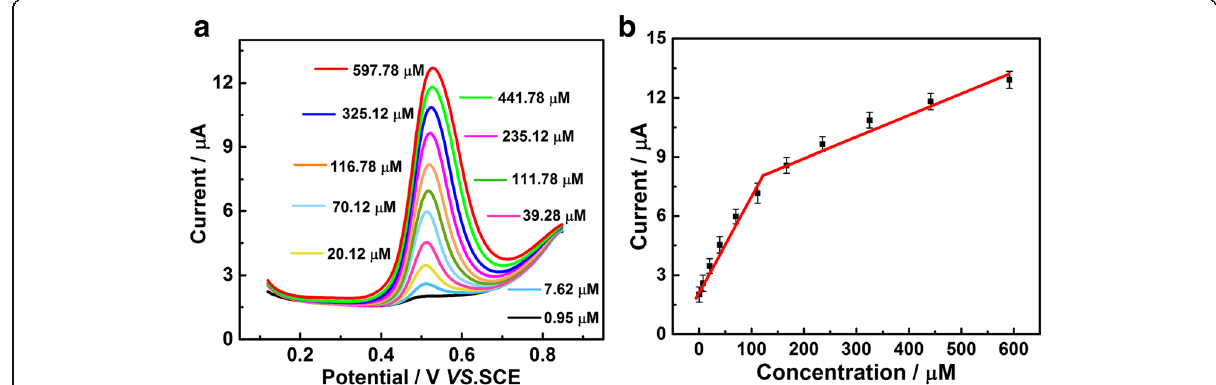
Fig. 3 DPV of the 0.136 μ g PtNi/C-modified electrode in 0.1 M BR buffer solution (pH = 2.0) solution containing different concentrations of CA ( a ) and the plots of oxidation currents versus the concentration of CA ( b